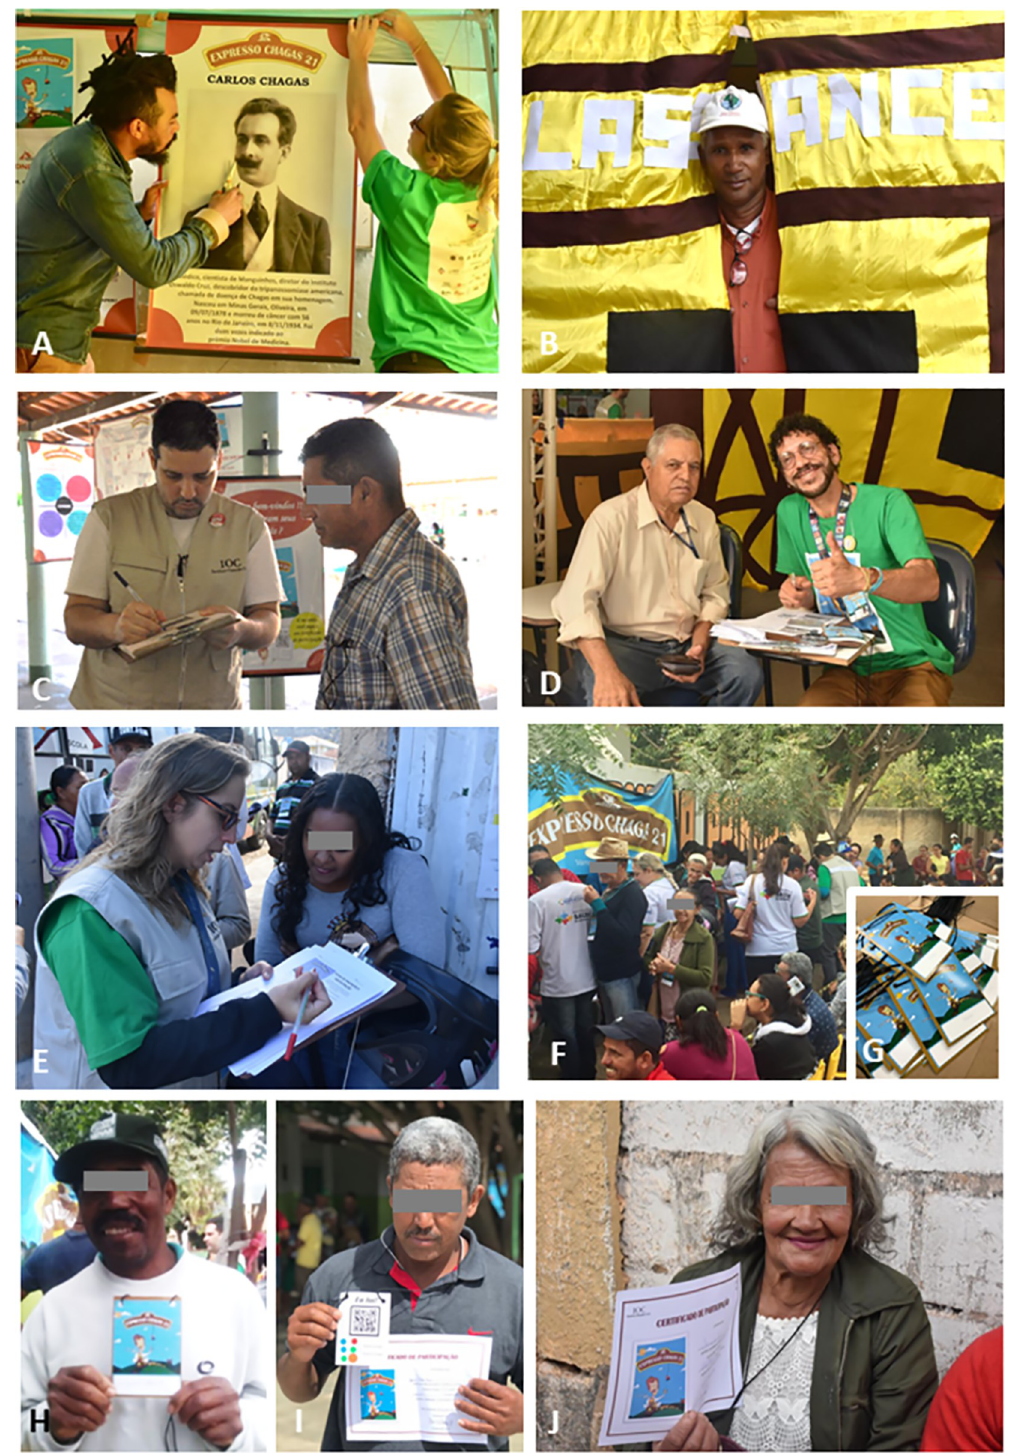
Fig 2. Images of the Station entry and exit points: (A) Setting up the exhibition and presenting Carlos Chagas, the scientist who discovered the disease in 1909; (B) Scenography of the exhibition entry named station “Lassance”, alluding to the village where the discovery took place; (C,D,E) Filling forms for each visitant; (F) crowded waiting line to attend the activities in a local school at Espinosa city, Minas Gerais; (G) a set of badges (identification cards) for the visiting public. Note the green T- shirt that identified the field team of the project (A,D,E) and the field jacket (C) that is used in field institutional missions (C, D); (H,J) proud visitants showing their front (H) and back (I) views of their badge and certificate (J) smiling to express joy and